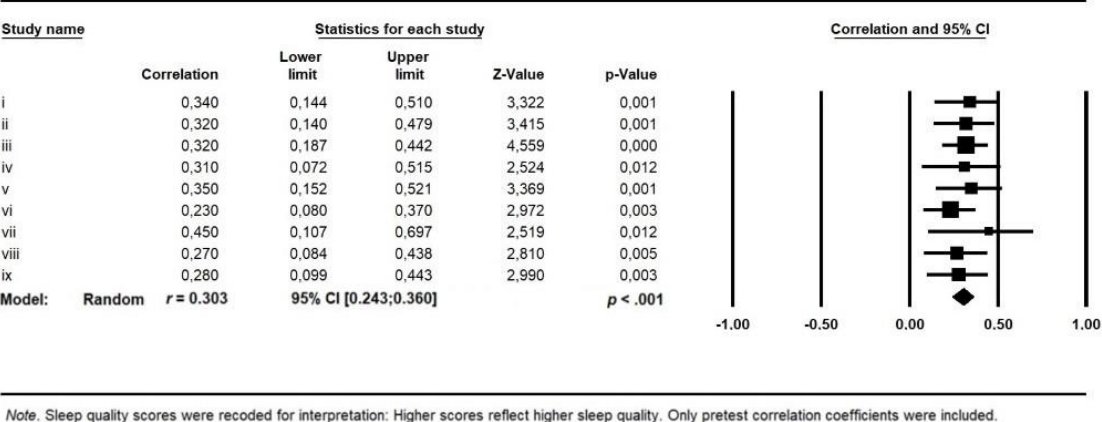
Figure 1. Meta-analysis results for SC-SQ-corrections of nine studies.